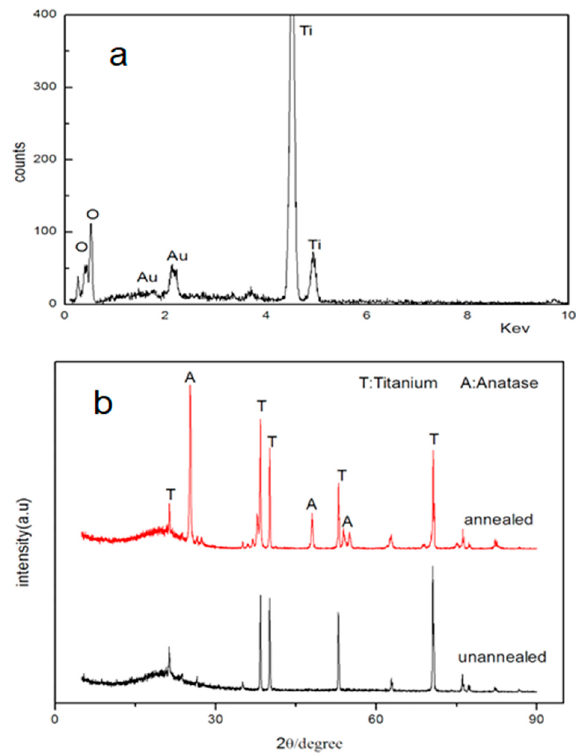
Figure 4. ( a ) EDS microanalysis of nanotubes and ( b ) XRD spectra of the nanotubular layers before and after annealing at 550 °C for 3 h.